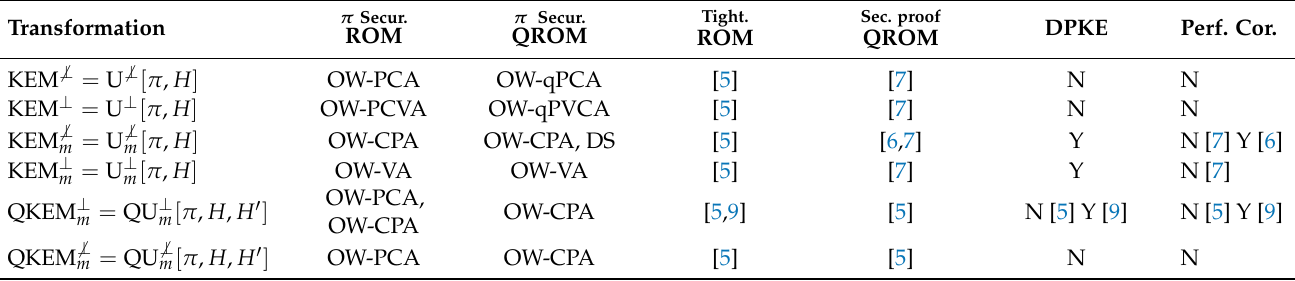
Table 5. Transformations and the security proof